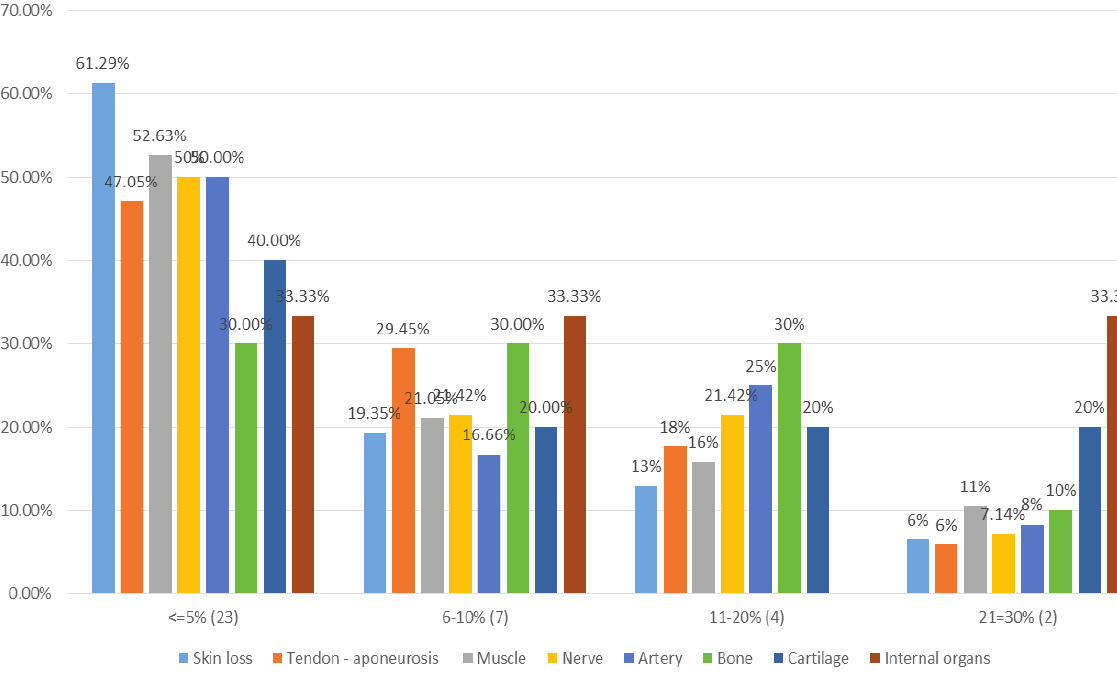
Figure 2: Patients with differential deep structures damage per TBSA